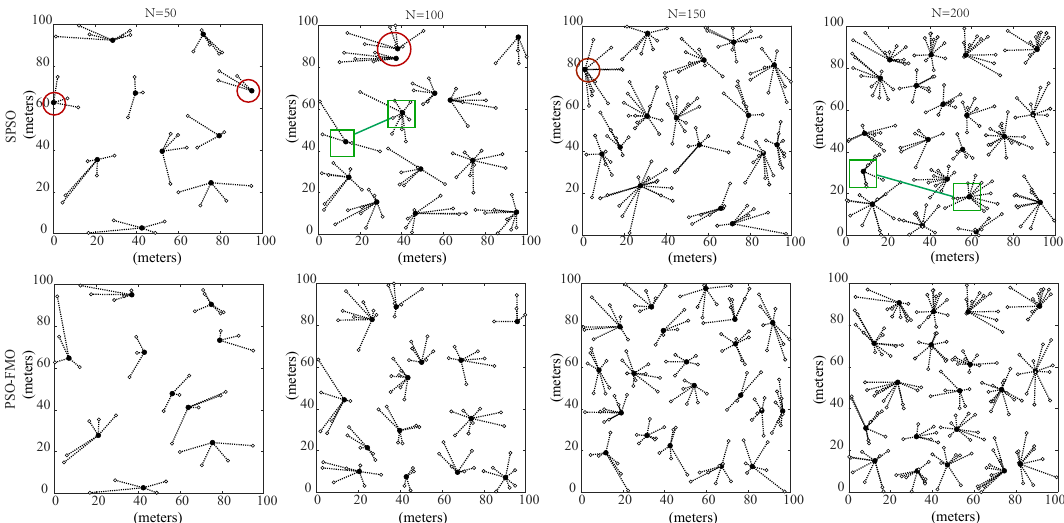
Figure 5. Clustering results of sensor nodes based on SPSO and PSO-FMO in terms of different number of sensor nodes 50, 100, 150 and 200. The clusters highlighted by circles have extremely asymmetrical centroids; while the clusters highlighted by square show the imbalance of the number of sensor nodes between clusters, which is the result of SPSO.